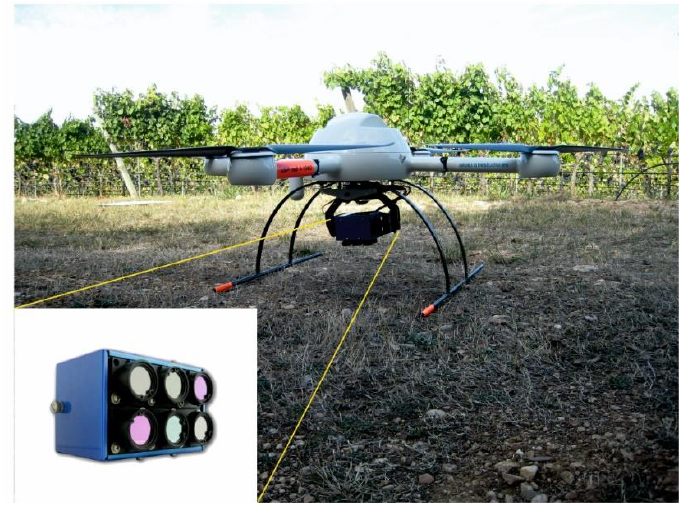
Figure 2. Multispectral camera mounted on the RPAS Md4-1000 and detail of the multiple camera